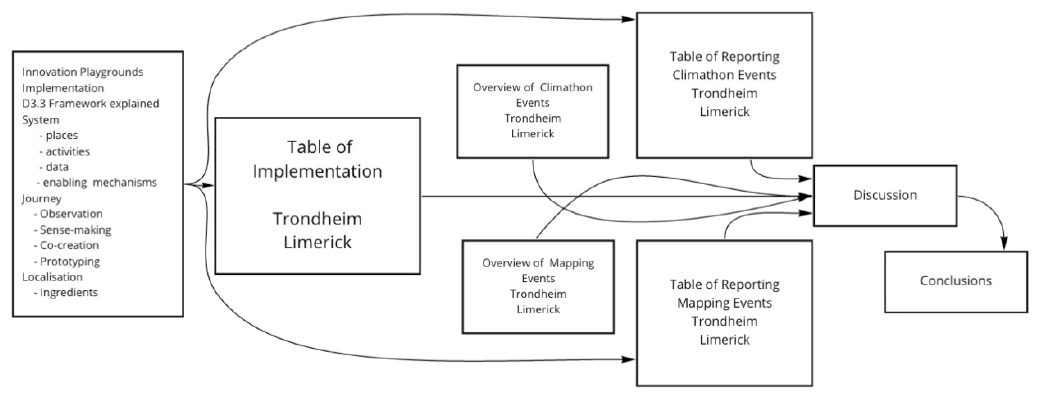
Figure 5. Structure of this